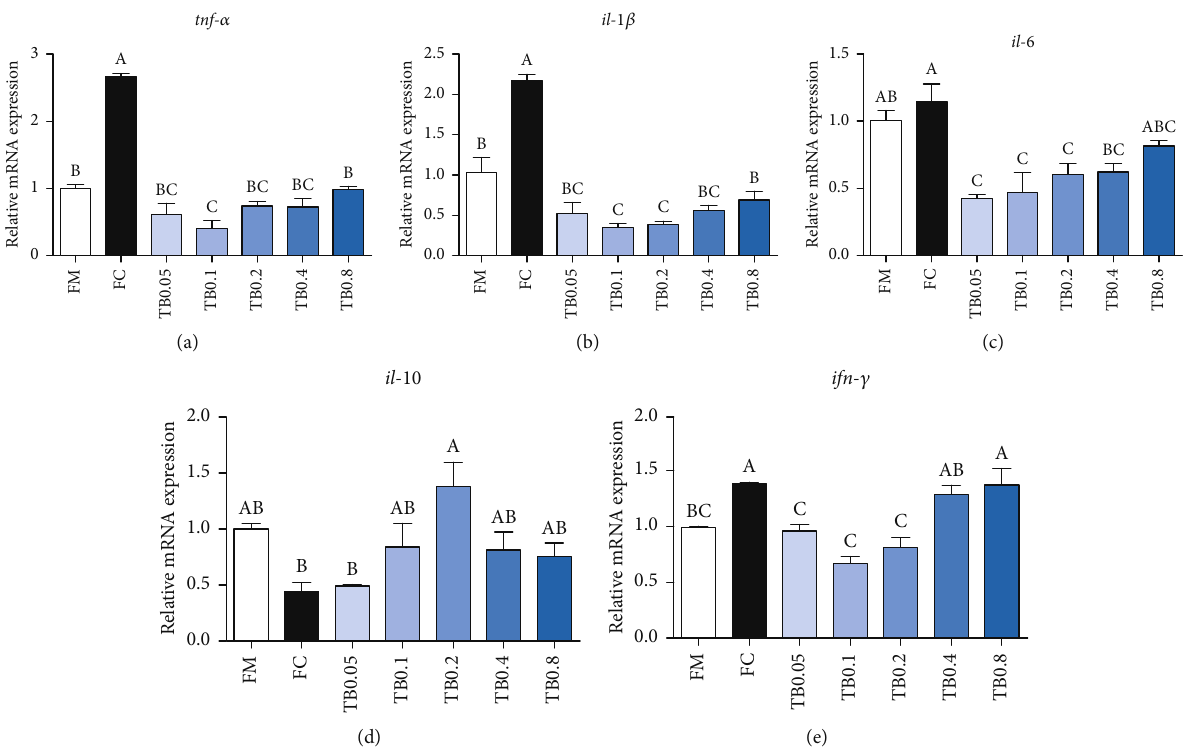
Figure 3: E ff ects of tributyrin supplementation on the expression of in fl ammation-related genes in the intestine of juvenile large yellow croaker fed diets with high level of Clostridium autoethanogenum protein replacing fi sh meal. Values are means ( n = 3 ), with the vertical bars represent the standard error. Data in bars sharing the common letters indicated no signi fi cant di ff erence determined by Tukey ’ s test ( P > 0 : 05 ). tnf α : tumor necrosis factor α ; il-1 β : interleukin-1 β ; il-6 : interleukin-6; il-10 : interleukin-10; ifn γ : interferon γ